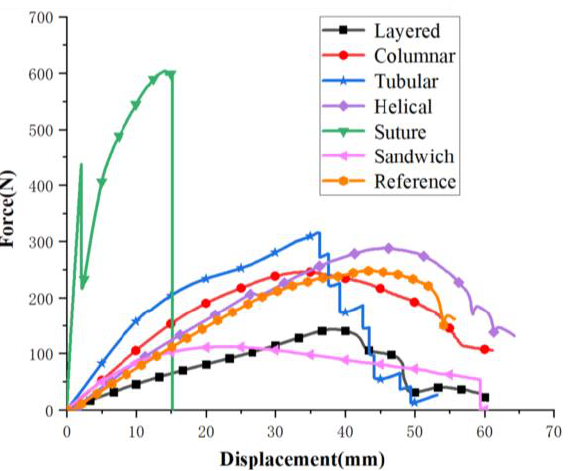
Figure 21. Analysis of experimental results of the six bionic structures and the reference model.